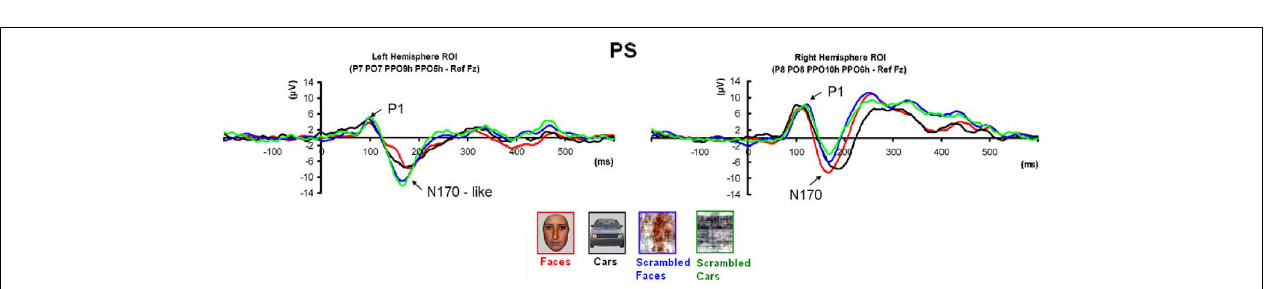
FIGUREA2 | Grand averaged of all repetitions of the experiment performed by PS but with Fz as a